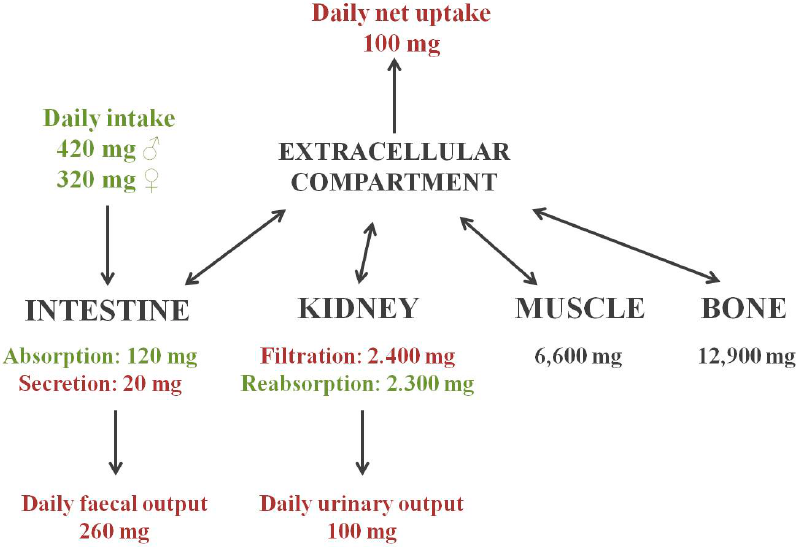
Figure 1. Overview of magnesium homeostasis.